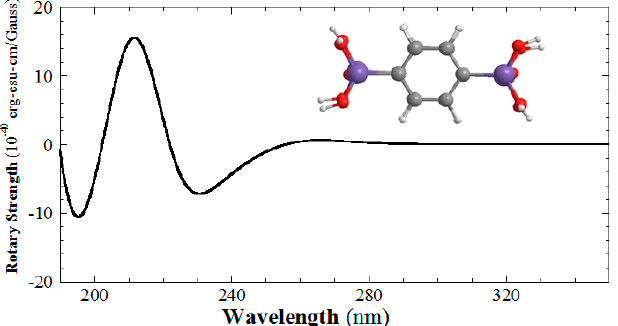
Figure 7. Simulated circular dichroism (CD) spectrum of the 1,4-phenylene-bridged bis(silsesquioxane) dimer at the B3LYP/6-311++G** level with right-handed stacking of phenylene